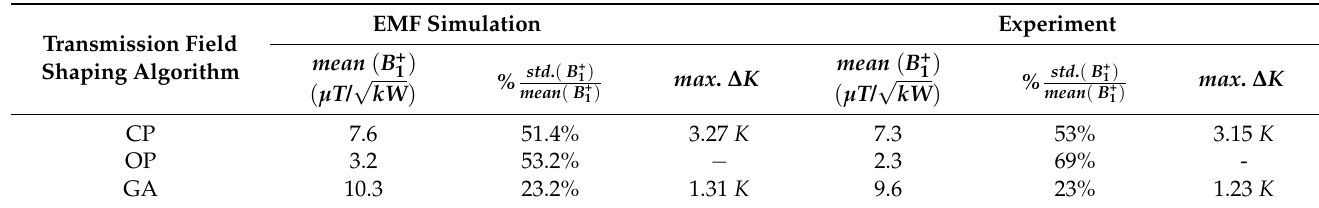
Table 1. Summary of statistical B + parameters and maximum temperature increase derived from 1 numerical EMF simulations and phantom experiments using the CP, OP, and GA approaches for transmission field